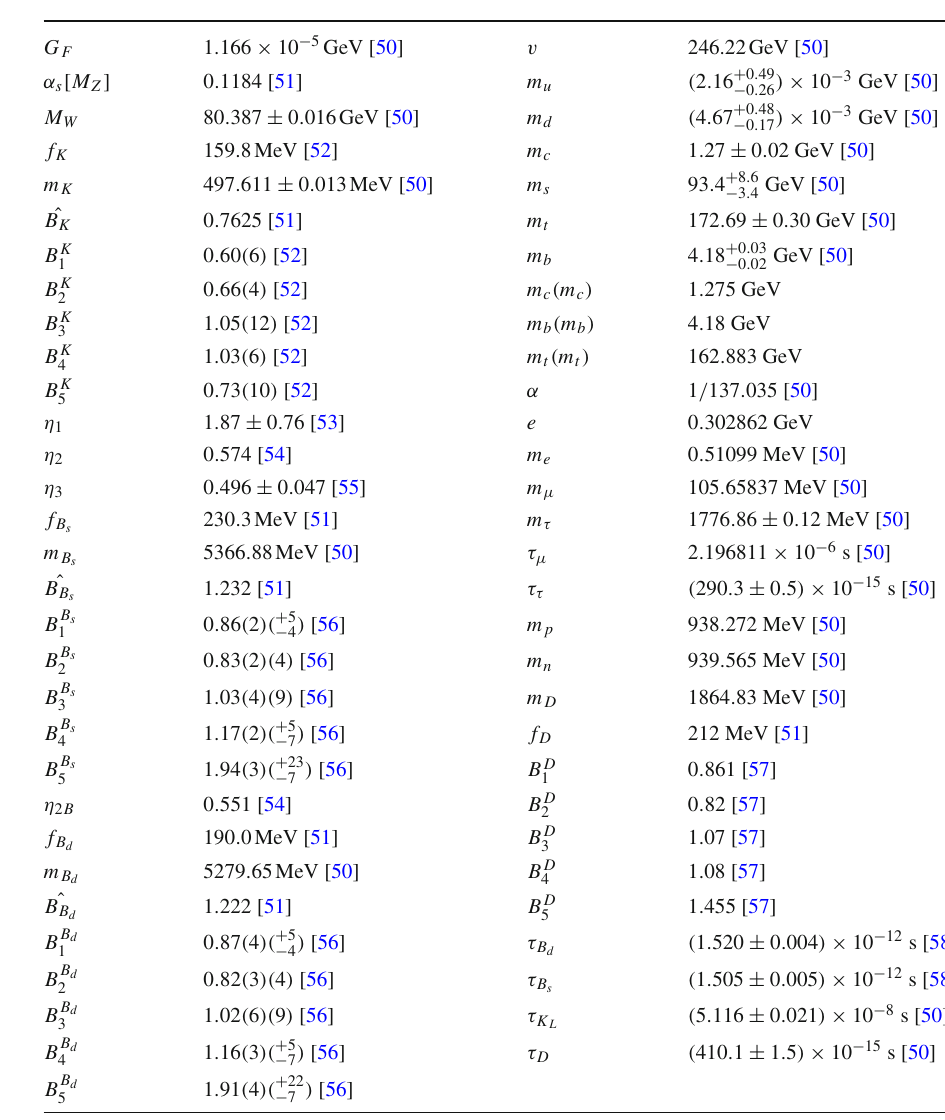
Table 6 Values of the experimental and theoretical quantities used as input